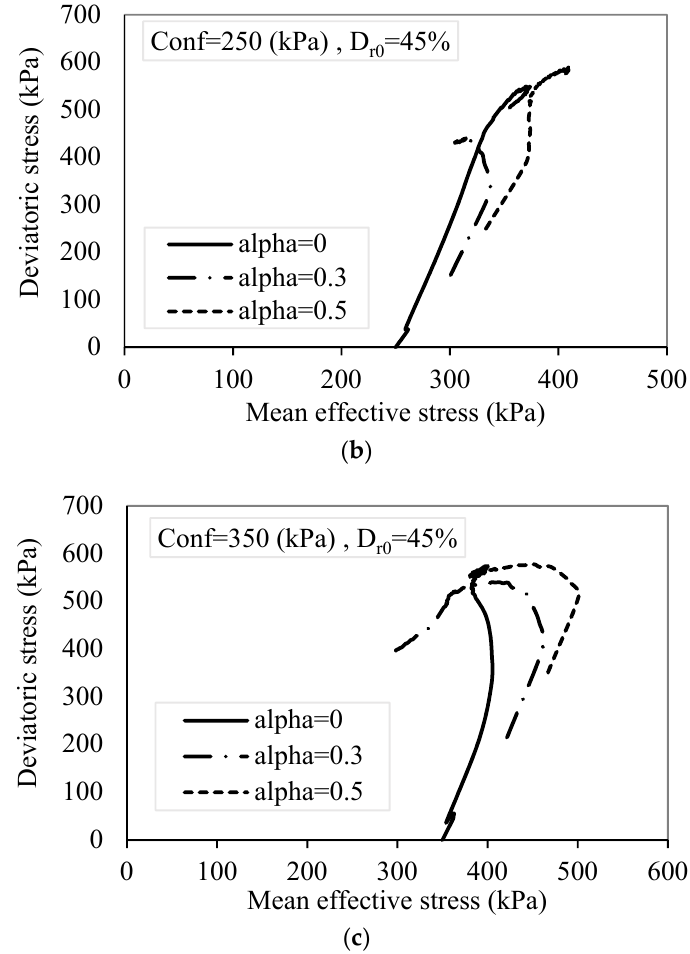
Figure 9. Effective stress paths at a different effective confining pressure: ( a ) 159 kPa; ( b ) 250 kPa; ( c ) 350 kPa in isotropic and anisotropic stress condition for Dr 0 = 45%. Alpha ( α ): the initial shear stress ratio.